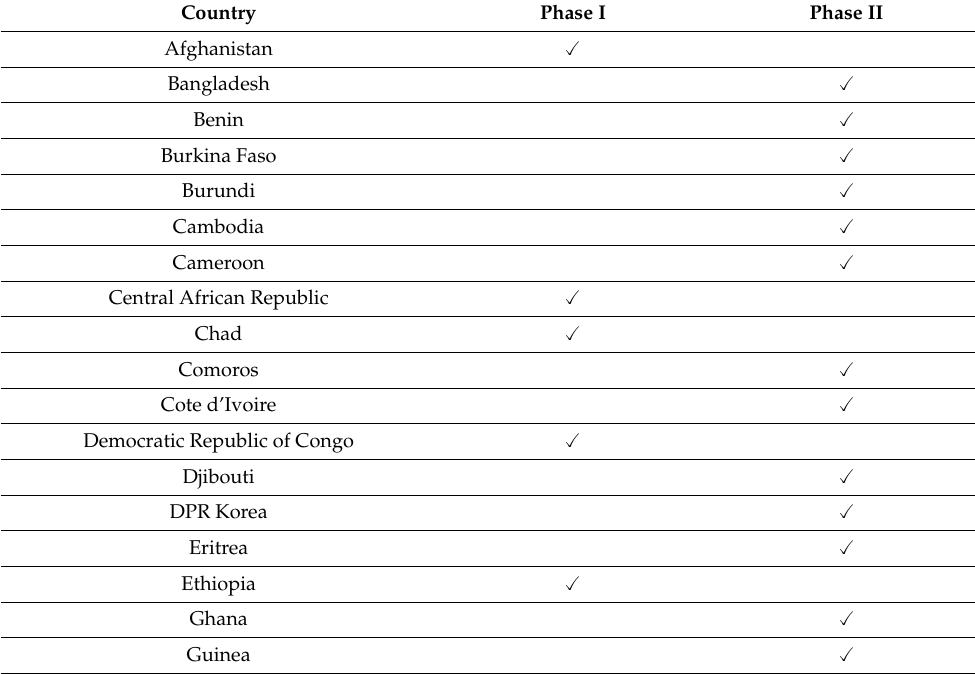
Table A1. Gavi-supported countries included in phases I and II of the